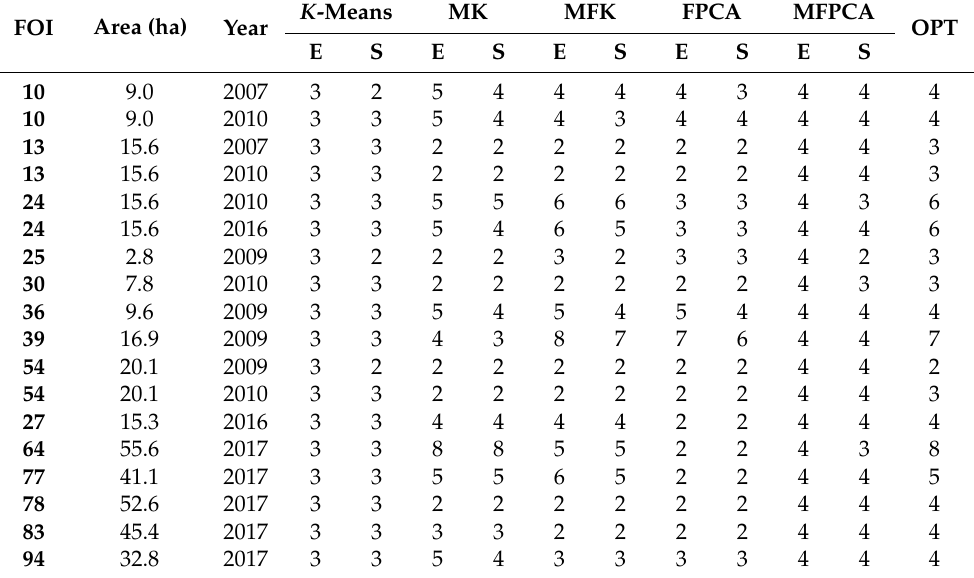
Table 1. The number of expected classes (E) detected by the five clustering methods (see text for the abbreviations) and the corresponding number of significant different classes (S) obtained from polygon kriging yield comparisons over the whole validation set. The last column sows the optimum number of classes (OPT), assumed as the maximum of S for each